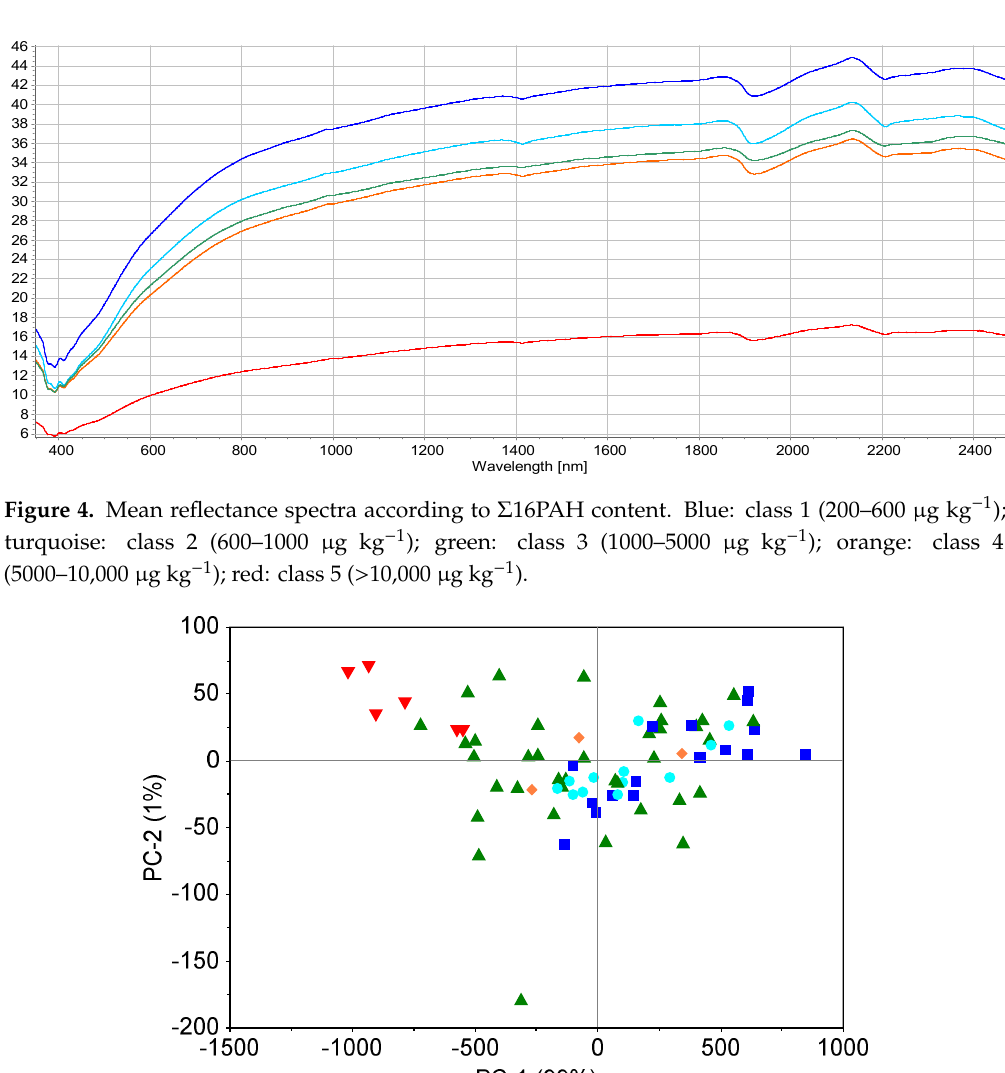
class 1 (200–600 µ g kg − 1 ); turquoise: class 2 (600–1000 µ g kg − 1 ); green: class 3 (1000–5000 µ g kg − 1 ); class 1 (200–600 µg kg −1 ); turquoise: class 2 (600–1000 µg kg −1 ); green: class 3 (1000–5000 µg kg −1 );